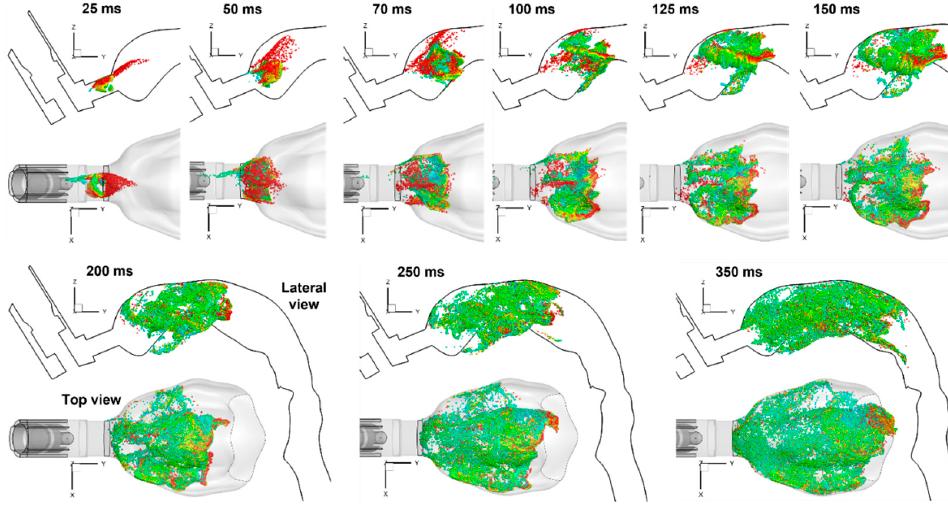
Figure 8. Snapshots of spray aerosols with lateral and top views at varying instants after MDI actuation at Q max = 60 L/min. The aerosol symbols are colored according to their individual diameters.